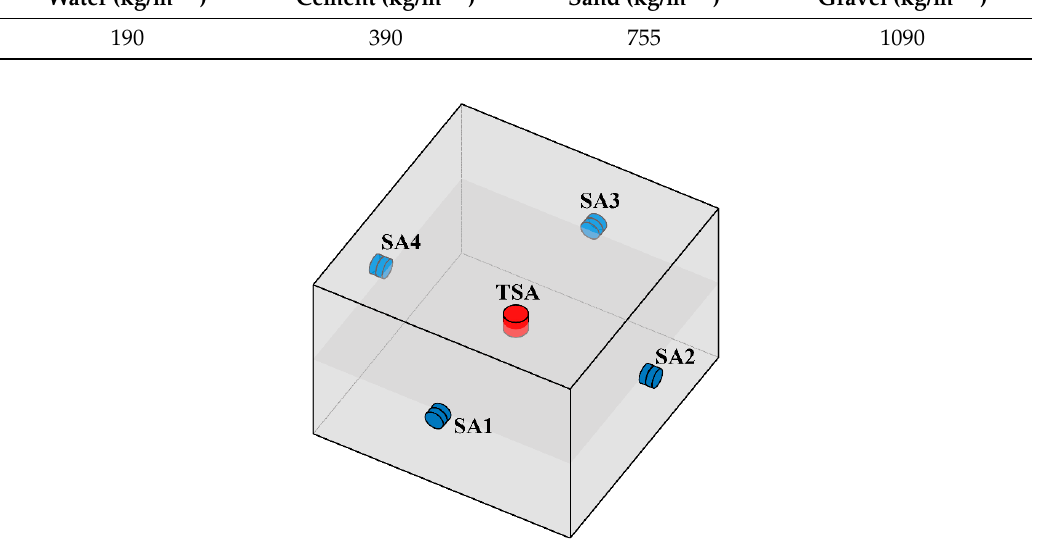
Figure 4. The diagram of the concrete specimen with embedded TSA and surface-bonded smart aggregates (SAs).